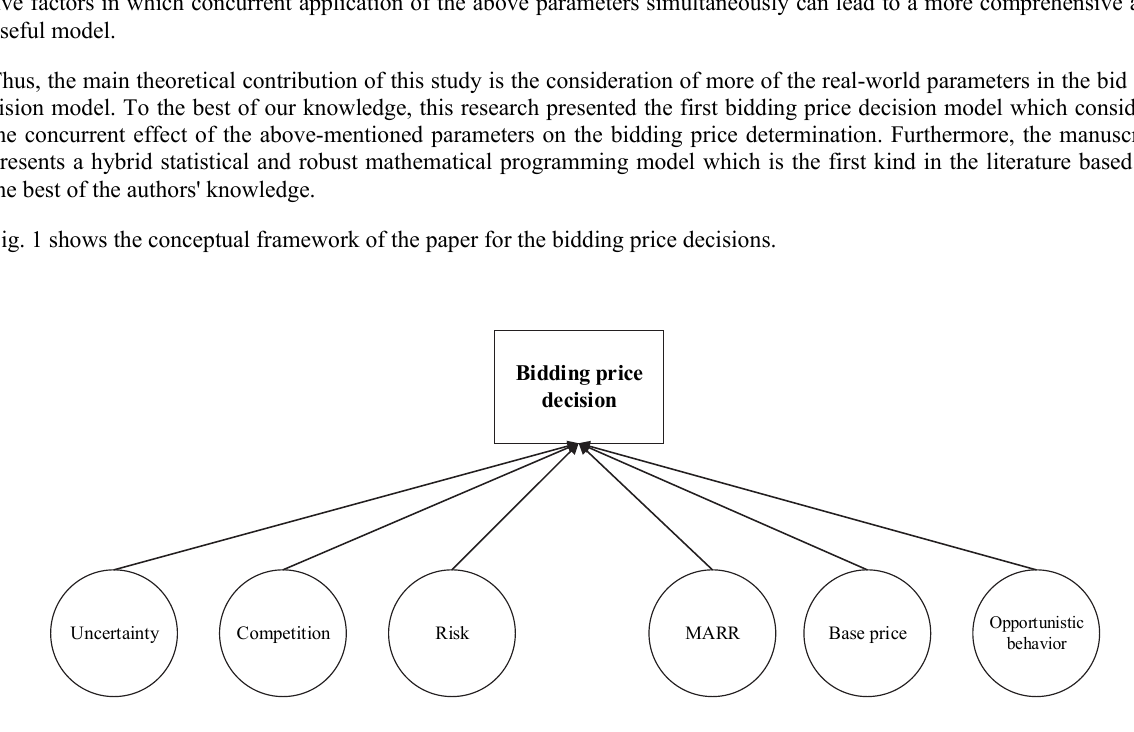
Fig. 1. The conceptual framework for bidding price